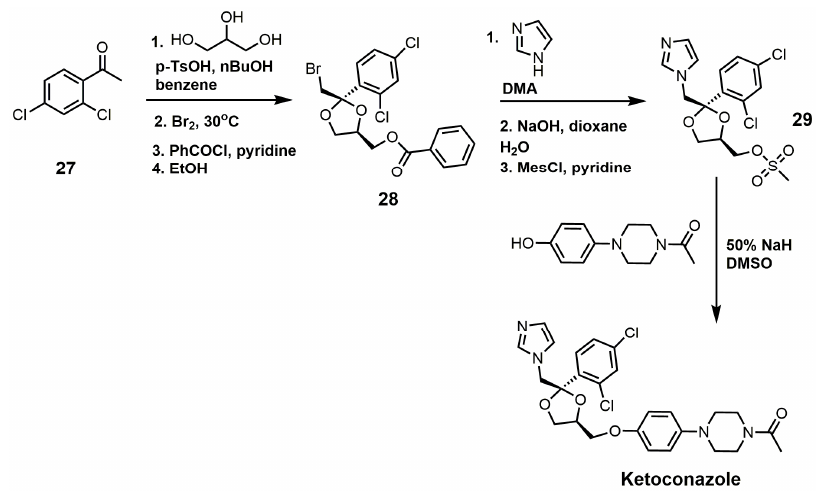
Figure 14. Synthesis of ketoconazole. Figure 13. Synthesis of [4- 18 F]fluconazole.